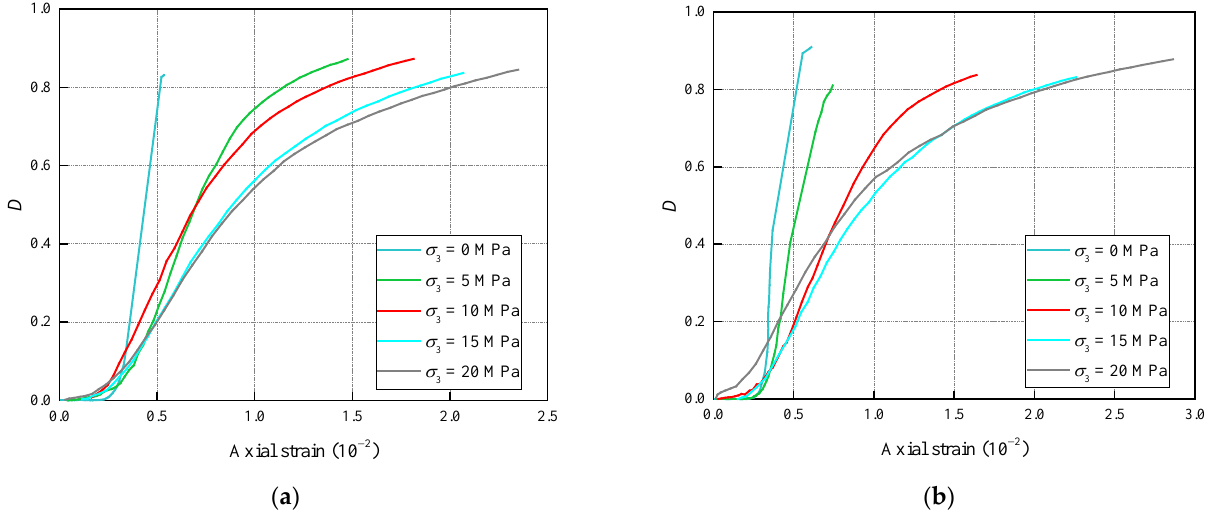
Figure 9. Relationship between damage variable D and axial strain. ( a ) C60 and ( b ) C70.